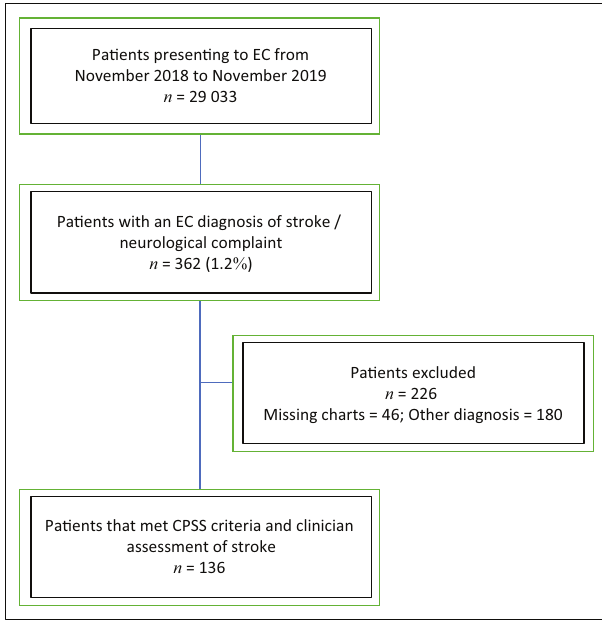
FIGURE 1: Breakdown of study